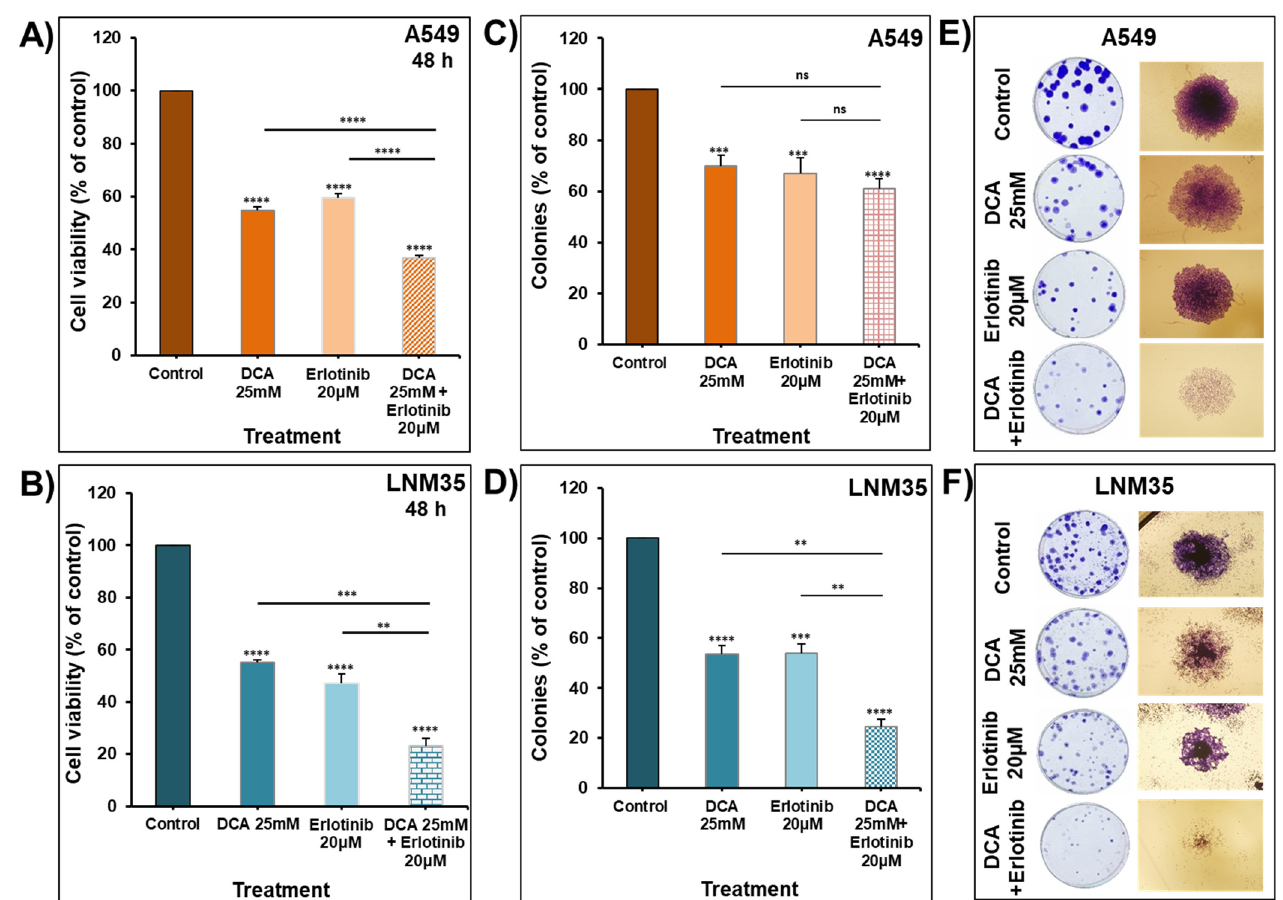
Figure 11. Effect of DCA in combination with erlotinib on NSCLC cells’ viability and colony growth. Exponentially growing A549 ( A ) and LNM35 ( B ) cells were treated, respectively, with DCA (25 mM) ± erlotinib 20 µM. Cellular viability was determined using CellTiter-Glo luminescent assay. ( C , D ) Treatment of the pre-formed colonies of A549 and LNM35 cells, respectively, with DCA (25 mM) ± erlotinib 20 µM for 7 days, after which colonies were fixed, stained and counted as described in the Materials and Methods. ( E , F ) Representative images of the colonies for the control and treated groups are shown for A549 and LNM35 cancer cells. All experiments were repeated at least 3 times. Columns are means; bars are S.E.M. ** Significantly different at <0.01. *** Significantly different at <0.001. **** Significantly different at <0.0001. ns—non- significant.